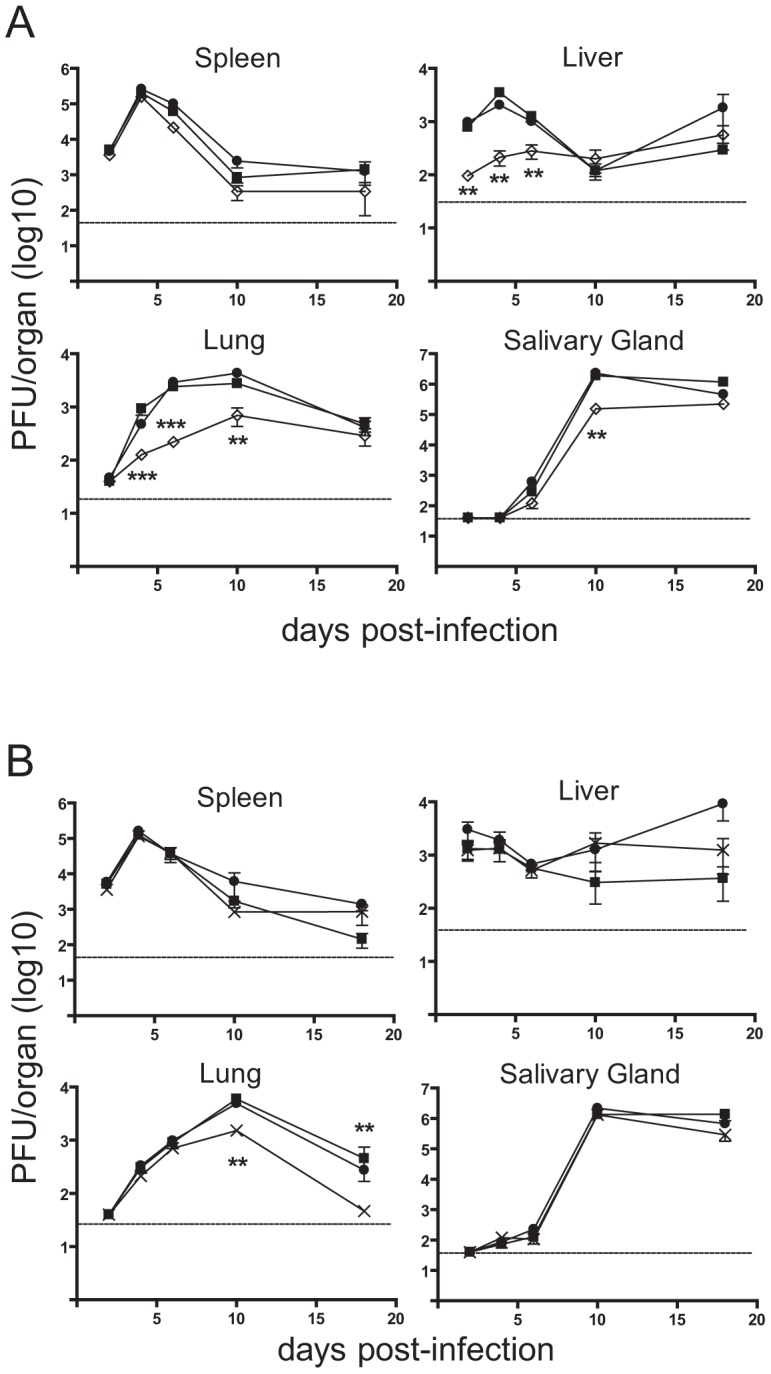
Loss of m41.1 or m41 impairs viral replication in vivo.(A) BALB/c mice were infected with WT MCMV (filled square), Rev (filled circle) or Δm41.1 mutant (open diamond), organs were removed at the indicated times pi and viral load determined by plaque assay, mean ± S.D. of 5–6 mice per time point is plotted. ** P<0.01, *** P<0.0001. Dotted line indicates the limit of detection of the assay. (B) BALB/c mice were infected with WT MCMV (filled square), Rev (filled circle) or the Δm41 mutant (cross), organs removed at the indicated times pi and viral load determined by plaque assay. Mean ± S.D. of 5–6 mice per time point is plotted. ** P<0.01. Dotted line indicates the limit of detection of the assay.